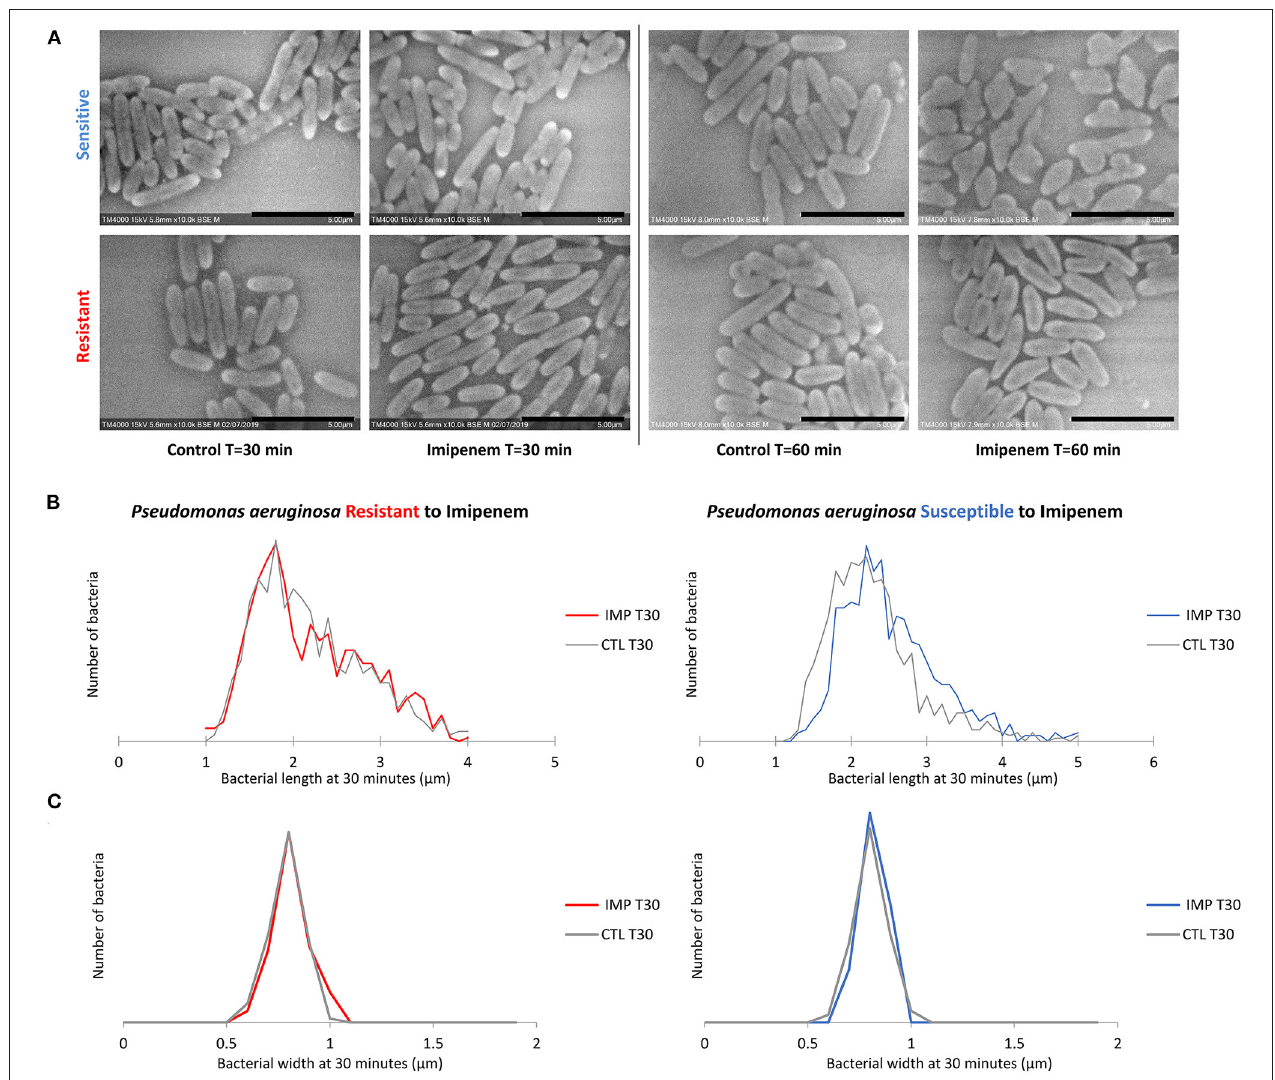
FIGURE 3 | Modifications observed on P. aeruginosa incubated with and without IPM for 30 and 60min. (A) Micrographs recorded on TM4000 Plus. Amorphous shapes observed at 60min in the susceptible isolates confirm the susceptibility of that isolate toward IPM. (B) Histograms showing length measurements at 30min of P. aeruginosa for both susceptible and resistant isolates. (C) Histograms showing width measurements at 30min of P. aeruginosa for both susceptible and resistant isolates. Scale bars: 5 µ